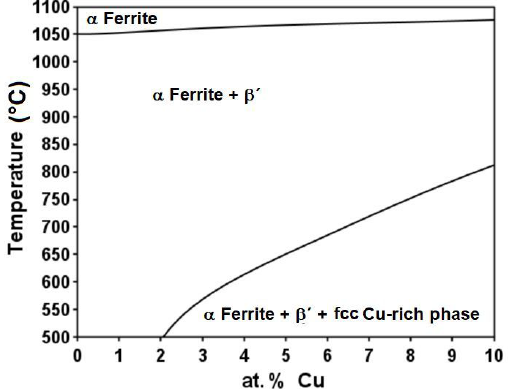
Figure 1. Calphad calculated equilibrium pseudobinary Fe-Cu phase diagram for Fe-10at.%Ni-15at.%Al-5at.%Cu